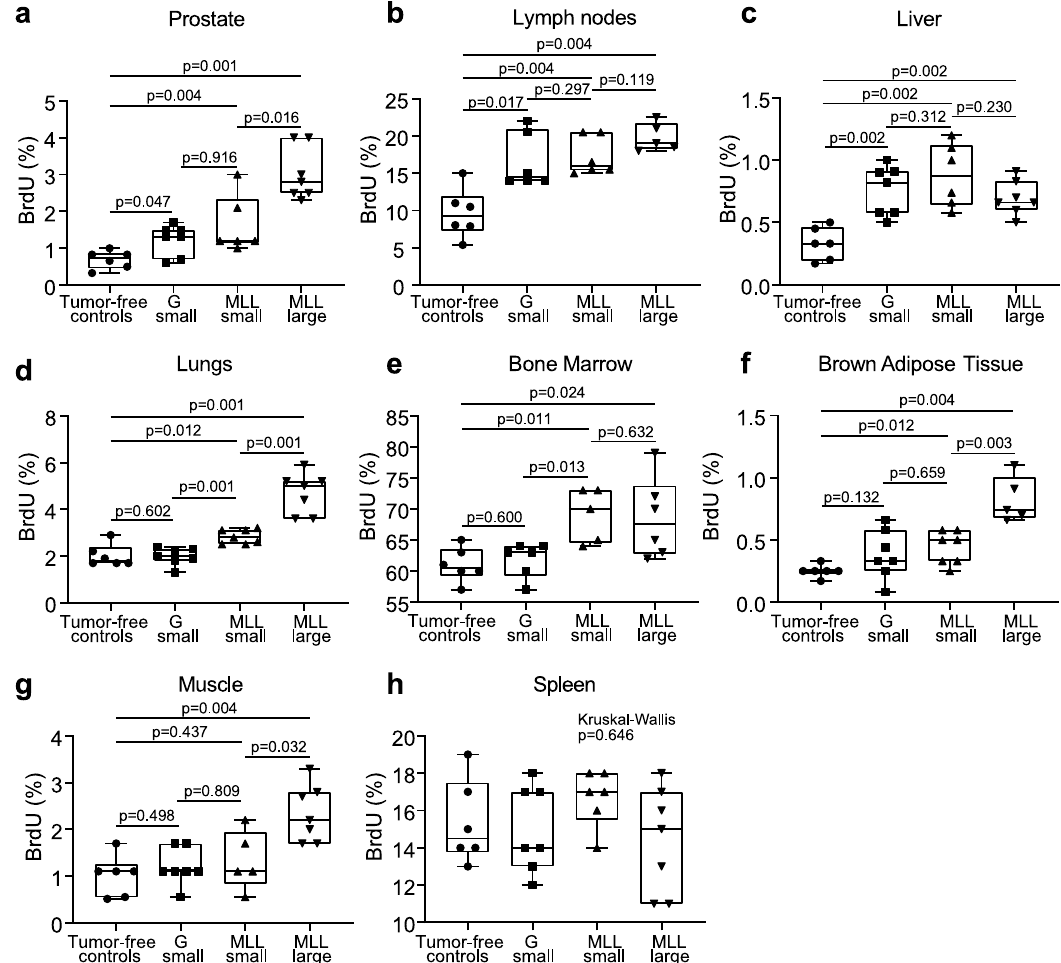
Figure 1. BrdU-labeling in various organs in animals with intraprostatic tumors. Box plots showing the volume density (%) of BrdU-labeled cells in the ventral prostate ( a ), regional lymph nodes ( b ), liver ( c ), lungs ( d ), bone marrow ( e ), brown adipose tissue ( f ), skeletal muscle ( g ), and spleen ( h ) in vehicle-injected tumor- free control rats and in rats with intra-prostatic G-small, MLL-small, or MLL-large tumors. Non-metastatic G-small tumors significantly increased BrdU-labeling in the prostate, lymph nodes, and liver. Metastatic MLL tumors significantly increased BrdU-labeling in the prostate, lymph nodes, liver, bone marrow, lungs, and brown adipose tissue. BrdU-labeling was significantly increased in a tumor-size dependent way in the prostate, lungs, brown adipose tissue and skeletal muscle but not in lymph nodes, liver, bone marrow or spleen. For each tissue examined, all four groups were compared using the non-parametric Kruskal–Wallis H test. If the multiple comparison showed significance (p < 0.05), the non-parametric Mann–Whitney U test was used to compare two An evenly distributed (non-focal) BrdU-labeling was observed in both liver and lungs. In the liver, BrdU + cells were mainly hepatocytes while CD68 + Kupffer cells were generally BrdU negative (Fig. 2d). In the lungs, double staining with BrdU and; (1) CD3 + T-lymphocytes, (2) CD68 + macrophages, (3) Cytoker- atin 7 + (CK7) pneumocytes, and (4) factor VIII + endothelium, showed BrdU-labeling in several cell types (Fig. 2e). In MLL-tumors, all tumor cells were CK7- and CD68-, while almost all tumor cells were BrdU + (data not shown). Collectively, tumors appear to induce DNA synthesis in various different cell types in the lung, but most prominent in pneumocytes. We then quantified the total volume density of BrdU + cells, and the volume densities of CK7 + /BrdU + and CD68 + /BrdU + cells in selected lungs from rats with orthotopic MLL-large tumors or from tumor-free con- trols. Again, volume density of total BrdU + cells in the lungs was significantly higher in rats with MLL tumors compared to controls (Fig. 2f). In addition, volume densities of BrdU + macrophages (CD68 + /BrdU +) and BrdU + pneumocytes (CK7 + /BrdU +) were also significantly higher in animals with orthotopic MLL-tumors compared to tumor-free controls (Fig. 2f). BrdU + macrophages and BrdU + pneumocytes together constituted approximately 80% of the BrdU + cells in lungs of animals with MLL-tumors, and were, when added together, also significantly higher in animals with MLL-tumors compared to controls (Fig. 2f). The volume density of remaining BrdU + cells (CD68-/CK7-/BrdU +) was low and did not significantly differ between animals with